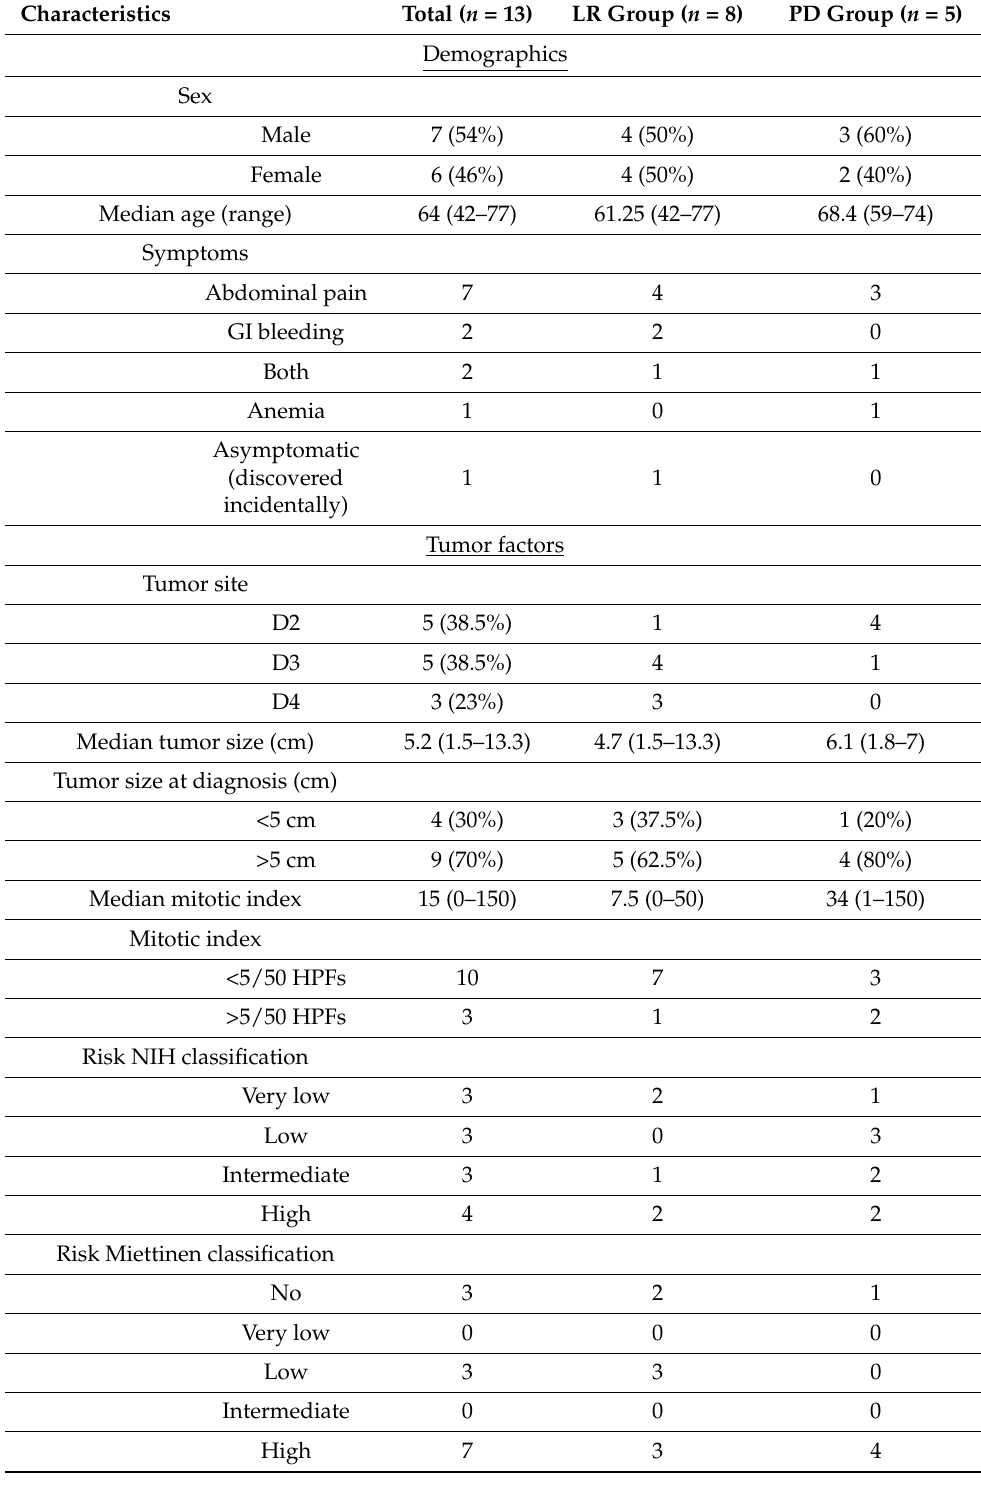
Table 1. Clinical and histopathological data and follow-up data of the whole cohort and of each group (LR vs.